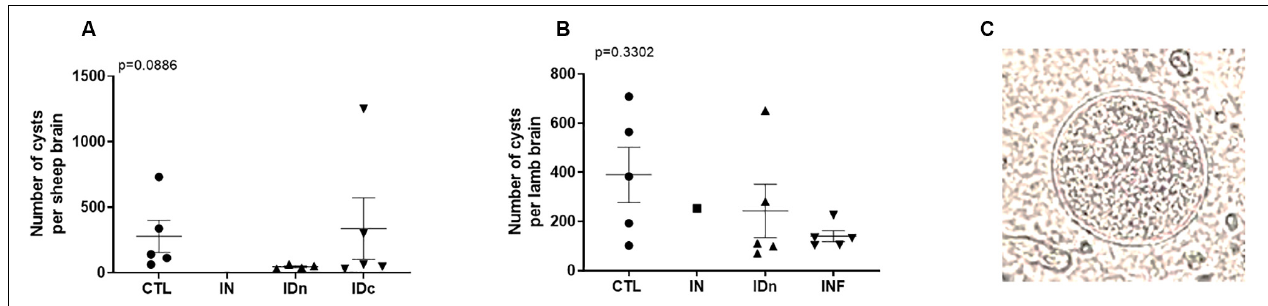
FIGURE 8 | Brain cysts numeration from (A) latent toxoplasmosis experiment and (B) transplacental transmission experiment. Brain cysts load were calculated related to their individual total volume. Data are expressed as plot and mean ± SEM. Statistical analysis was performed using Kruskall–Wallis test and was non-significant. (C) Representative picture of cyst observed with an optical microscope at an original magnification of x400.